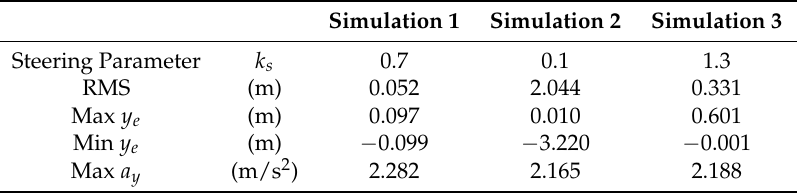
Table 3. Evaluation parameters for variation k s .